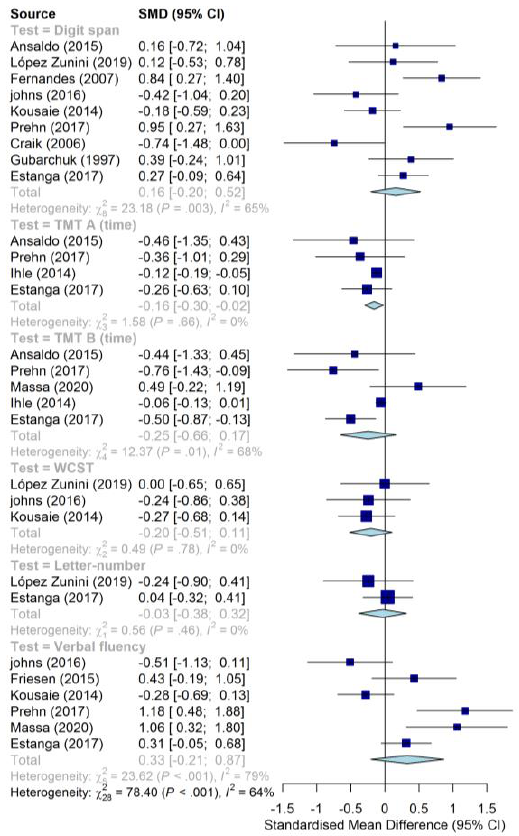
Figure 3. Forest plot for cognitive functioning in older bilinguals showing individual and pooled effect sizes. A positive standardized mean difference indicates a higher average score for the bilingual group. Table 4. Effect sizes of neuropsychological tasks that were used only once.